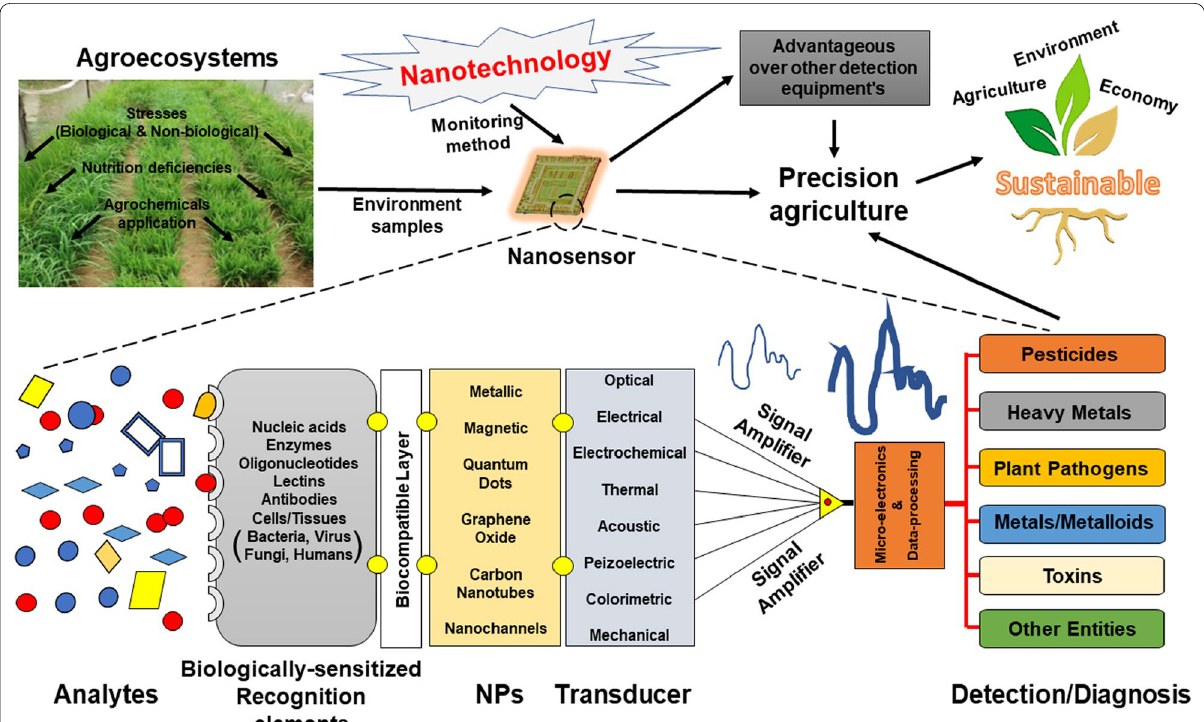
Fig. 2 Simplified representation illustrating the component of nanosensors to monitoring